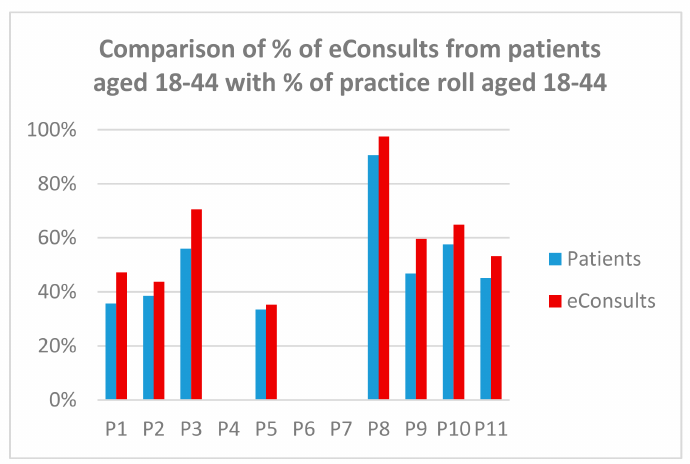
Figure 7. Comparison of the percentage of the eConsult submissions from patients aged 18–44 with the percentage of adult patients in that age group in the trial practices (excluding P04, P06 and